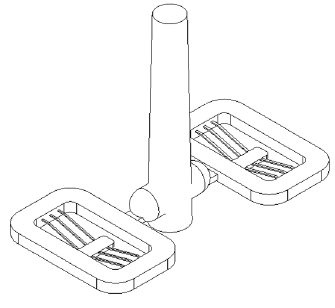
Figure 5. Melt delivery system.